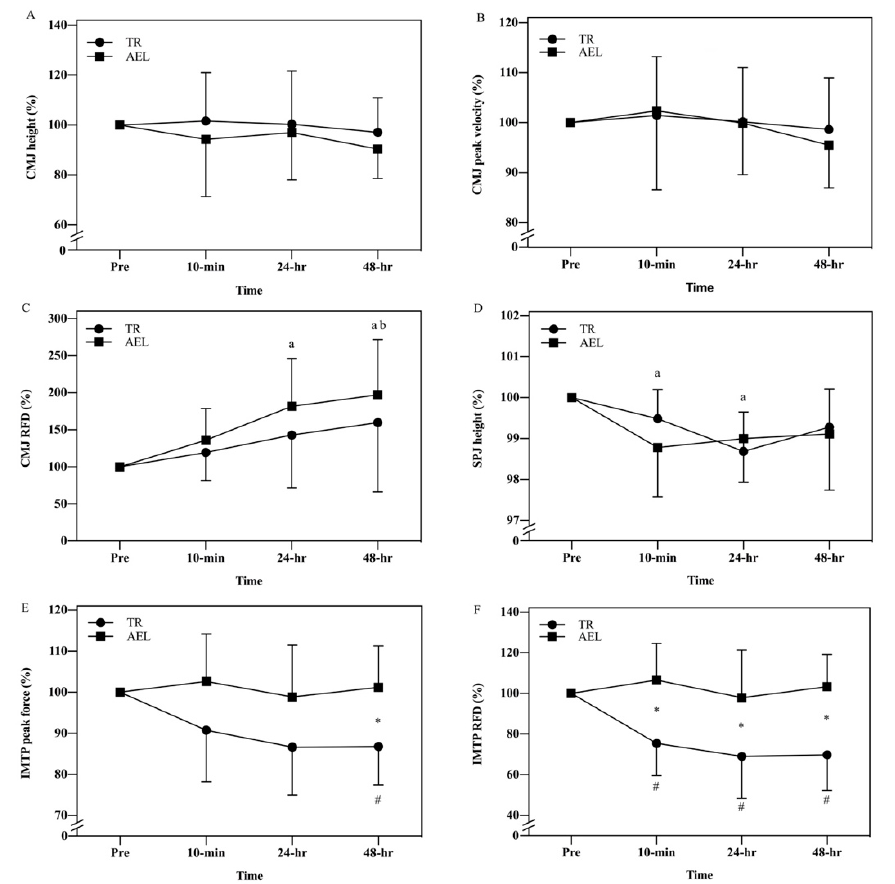
Figure 2. Normalized changes (expressed in percentage) in countermovement jump (CMJ) height ( A ), CMJ peak velocity ( B ), CMJ rate of force development (RFD) ( C ), spike jump (SPJ) height ( D ), isometric mid-thigh pull (IMTP) peak force ( E ), IMTP RFD ( F ) between accentuated eccentric loading exercise (AEL) and traditional resistance loading exercise (TR) group. * Denotes significant differences between AEL and TR. # Denotes significant differences from Pre in TR group. a Denotes significant main effect of time and post hoc differences from Pre. b Denotes significant main effect of time and post hoc difference from 24-hr.